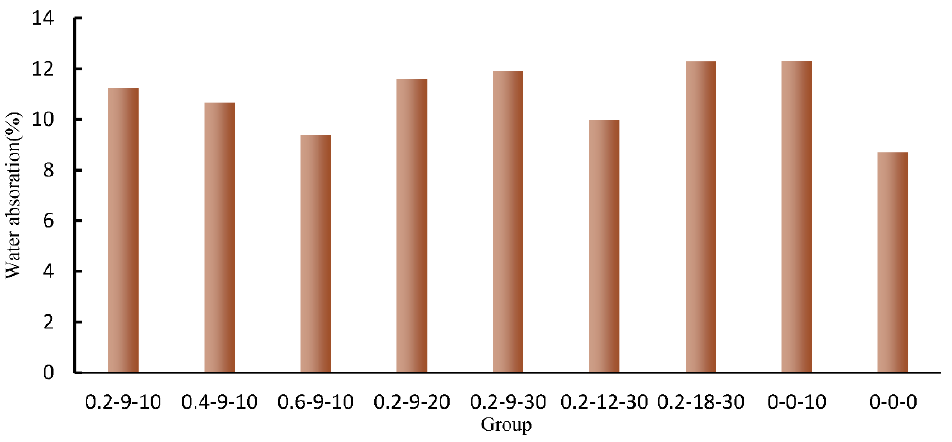
Figure 5. Curve of water absorption change.